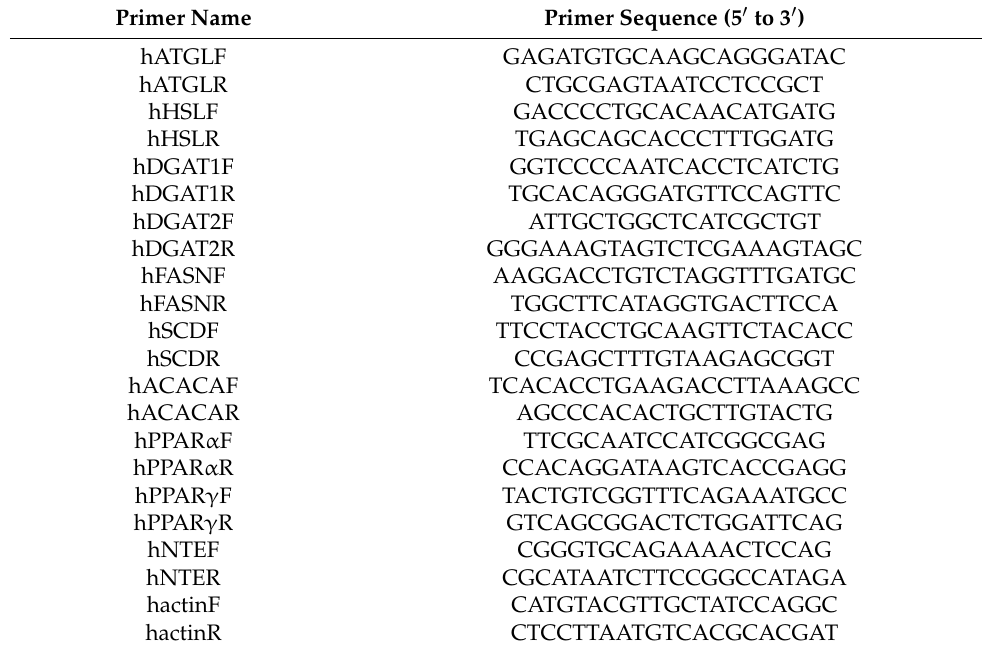
Table 2. Primers used in qPCR